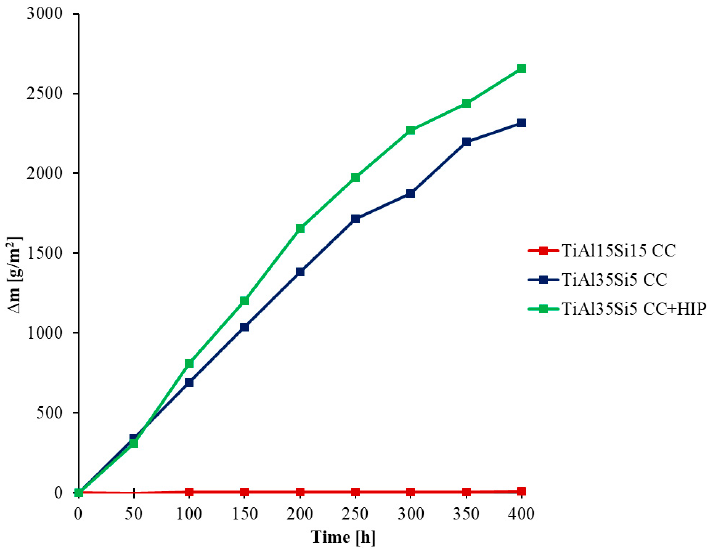
Figure 7. Dependence of the weight of delaminated oxides of Ti-Al-Si alloys on the time of cyclic oxidations (1000 °C; 400 h).